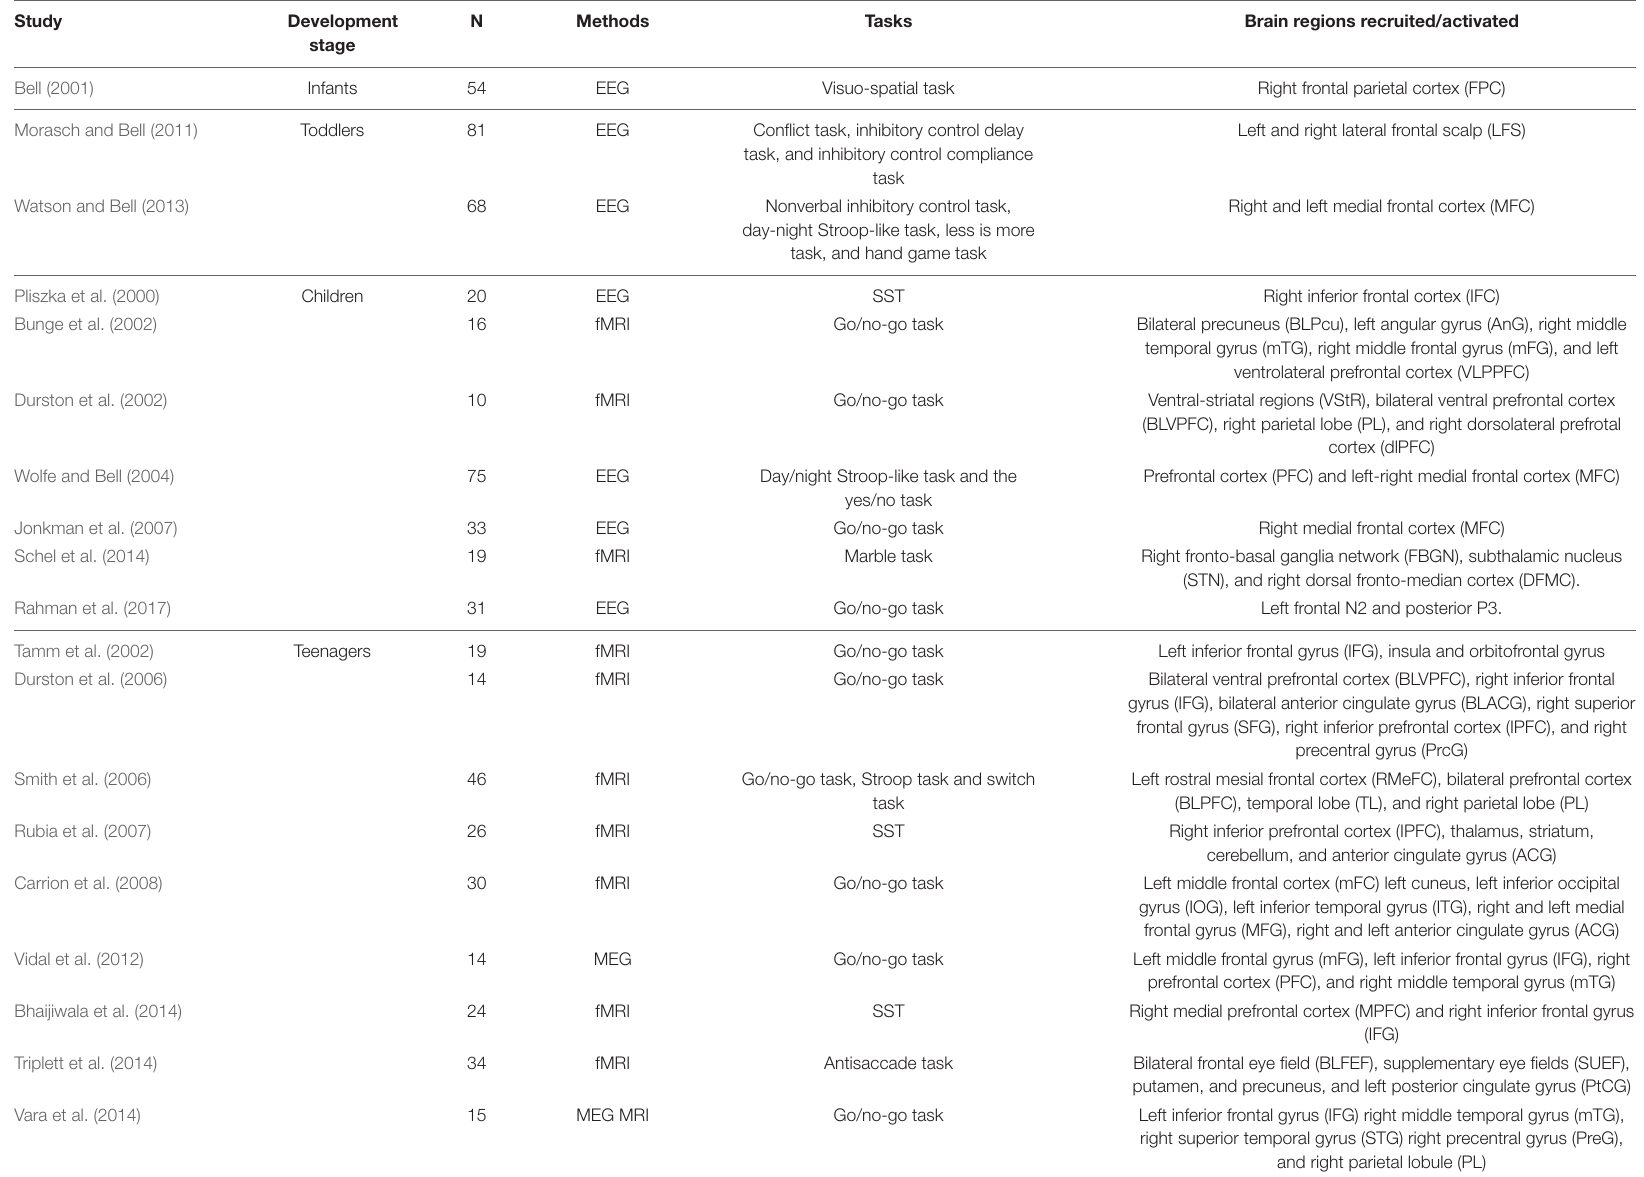
TABLE 1 | Information about studies, development stage, N, methods, tasks employed, and brain regions